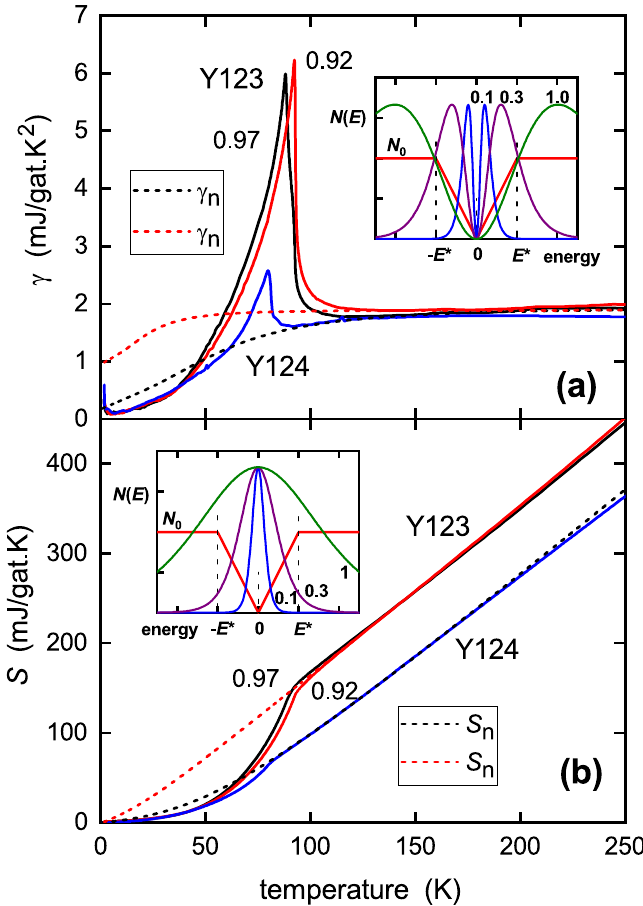
Figure 6. Comparison of ( a ) γ( T ) and ( b ) S ( T ) for Y124 with nearly fully-oxygenated Y123. At highest 0.97 , a double transition (see side-hump) is observed while a small depletion, x oxygenation, x = these merge into a single transition with a larger peak size. Above T c the γ( T ) curves merge while for S ( T ) they remain separated. The inset in ( a ) shows the double-peaked Fermi window, ∂ F /∂ T , for calculating γ( T ) using ( 1 f ln ( f ) f ) ln ( 1 f ) Eq. (2), where F ( E , T ) . The window is centred on a normal-state triangular = [ + − − ] gap in the DOS (red lines) located at E F . The blue, purple and olive-green curves show ∂ F /∂ T for temperatures 0.3 E 1.0 E 0.1 E k B T ∗ and ∗ , respectively. The inset in ( b ) shows the single-peaked Fermi window, ∗ , = calculating entropy, again centred on a triangular gap in the